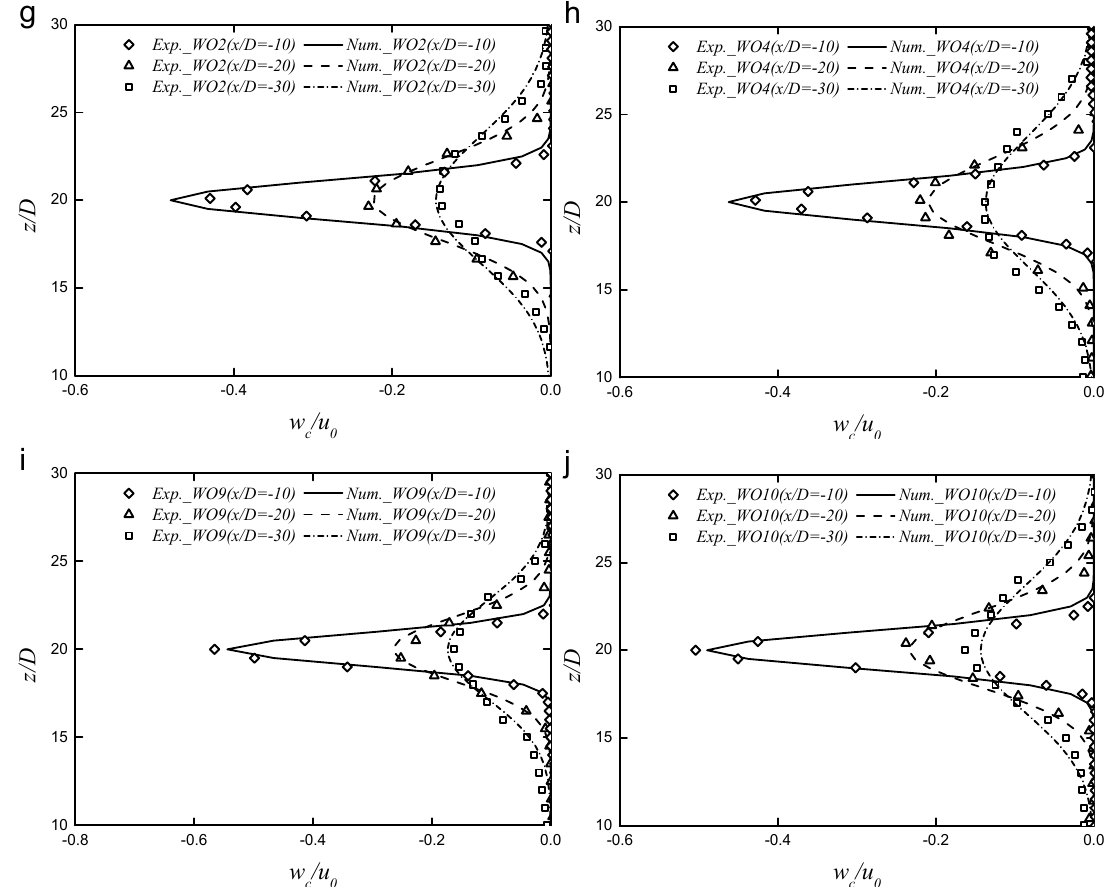
Figure 8. The time-averaged vertical velocity distributions for the experimental cases of ( a ) VW1, ( b ) VW3, ( c ) VW5 and ( d ) VW7; and the time-averaged horizontal velocity distributions for the experimental cases of ( e ) WC6, ( f ) WC8, ( g )WO2, ( h ) WO4, ( i ) WO9, ( j ) WO10.